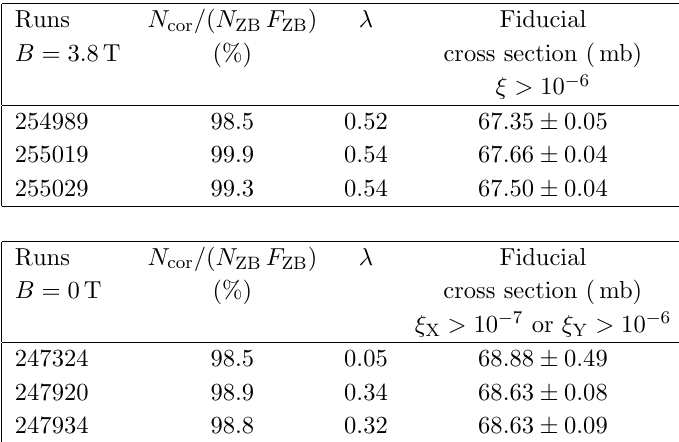
Table 1 . Overview of the noise-subtracted fraction of events ( N cor = ( N ZB F ZB )), average pileup ( (cid:21) ), and (cid:12)ducial cross section for all runs used in this analysis. The uncertainties in the noise-subtracted fraction of events and pileup have a negligible contribution to the uncertainty in the (cid:12)ducial cross section, which is quoted with its statistical uncertainty